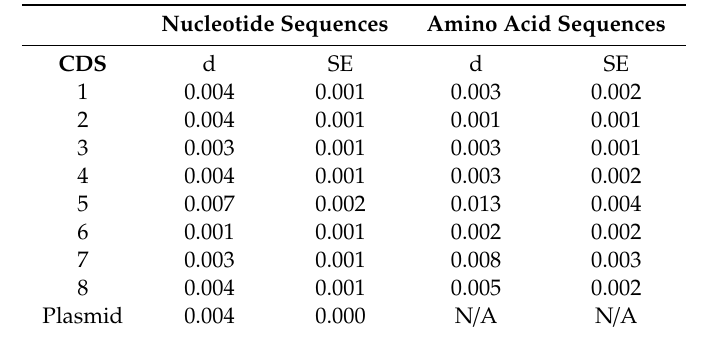
Table 3. The genetic distance d represents estimates of average evolutionary divergence over all sequence pairs for each coding sequence in isolation. The genetic distance of the entire plasmid is also shown for the nucleotide alignments, both coding and noncoding regions; amino acid comparisons cannot be made as not all nucleotides are in coding sequences. SE = standard error (1000 replicates). All numbers were rounded to 3 decimal